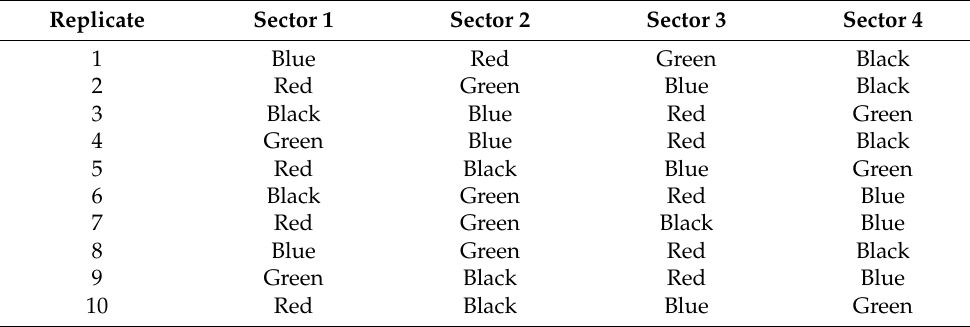
Table 1. Experiment #2. Sequence of placement of sector colors. Replicate Sector Replicate